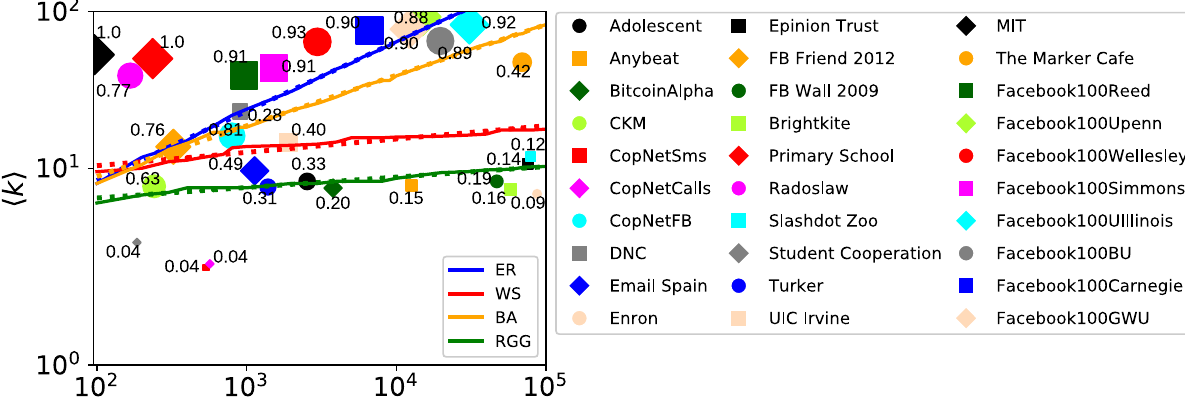
Figure 3. Lines representing uniqueness’ boundary ( U N = 0.5 ) in ER (blue), WS with β = 0.5 (red), BA (orange), and RGG (green) network models, in a log-log scale, and uniqueness of neighborhoods for 30 real-world networks (reported also in Table 1). The horizontal axis represents the network size n , while the vertical axis represents the average degree (cid:31) k (cid:30) . The area below the lines is the one with uniqueness < 0.5 , while above the lines the uniqueness is > 0.5 . The continuous lines are the ones computed with the simulations during a binary search process, while the dashed lines are the corresponding linear fits (that have equations log ( y ) = m × log ( x ) + c ). The dots correspond to the uniqueness of neighborhoods of the real world networks listed on the right, and their size is in according to their value of U N . The dots are placed in correspondence to the average degree and network size value of the